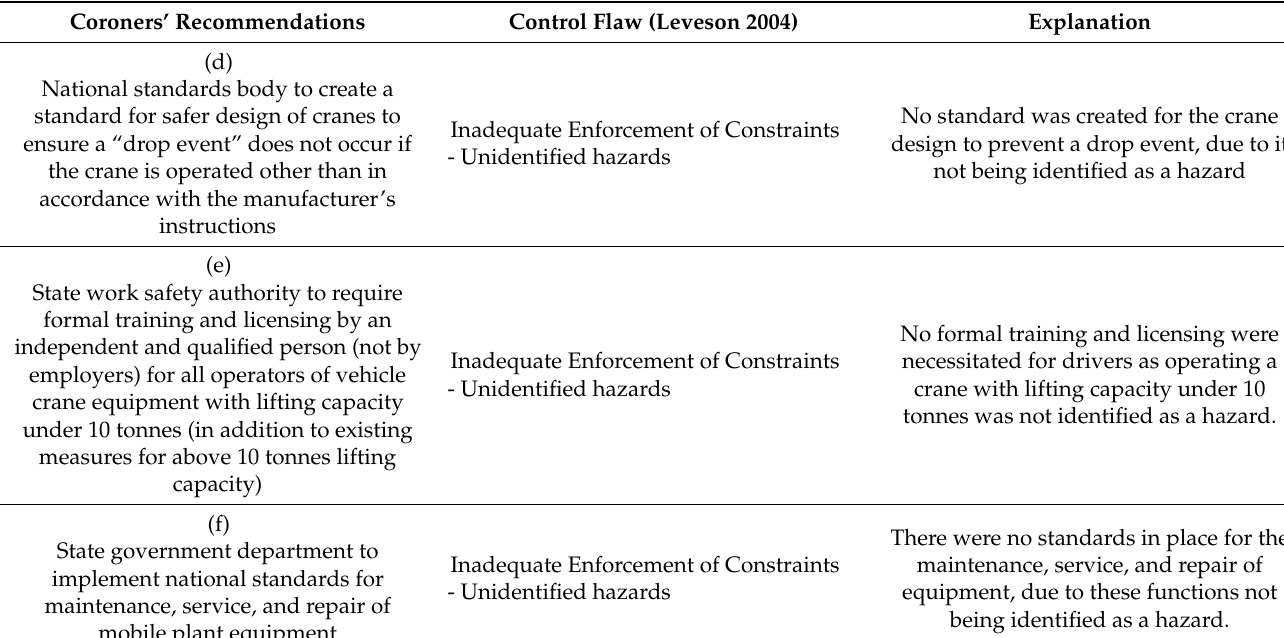
Table 7. Coroners’ Recommendations STAMP Mapped at Level 2—Regulators and Government Agencies and Assigned to a Control Flaw ( n =